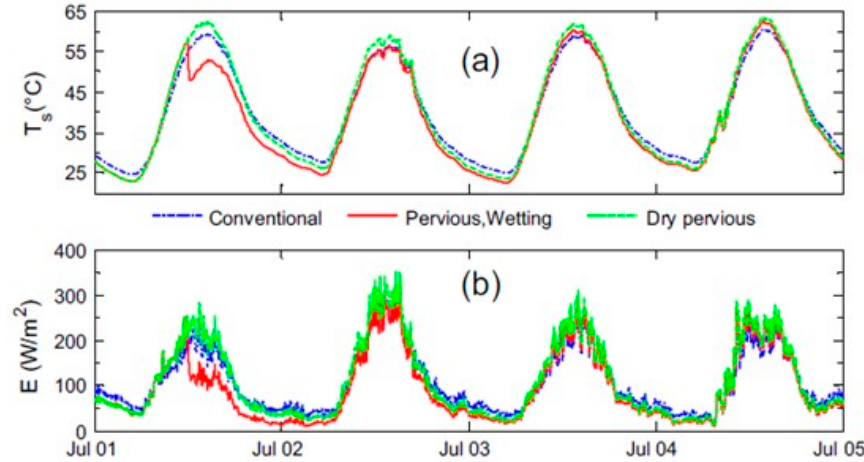
Figure 11. Thermal evolution of concrete at midnight, ( a ) temperature evolution, and ( b ) release of sensible heat [128].